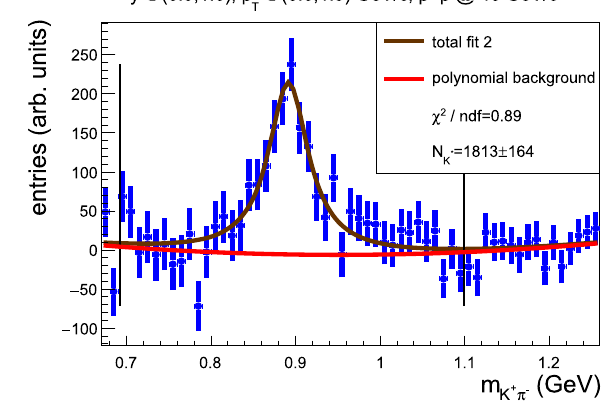
Fig. 3 Theexampleoftheprocedureofsignalextractionfor K ∗ ( 892 ) 0 inrapiditybin0 . 5 < y < 1 . 0(allrapidityvaluesinthepaperaregivenin the center-of-mass reference system) and transverse momentum range 0 < p T < 1 . 5 GeV / c for p+p collisions at 40 GeV / c . Left: data sig- nal (blue points) and fitted background (red line) obtained from the